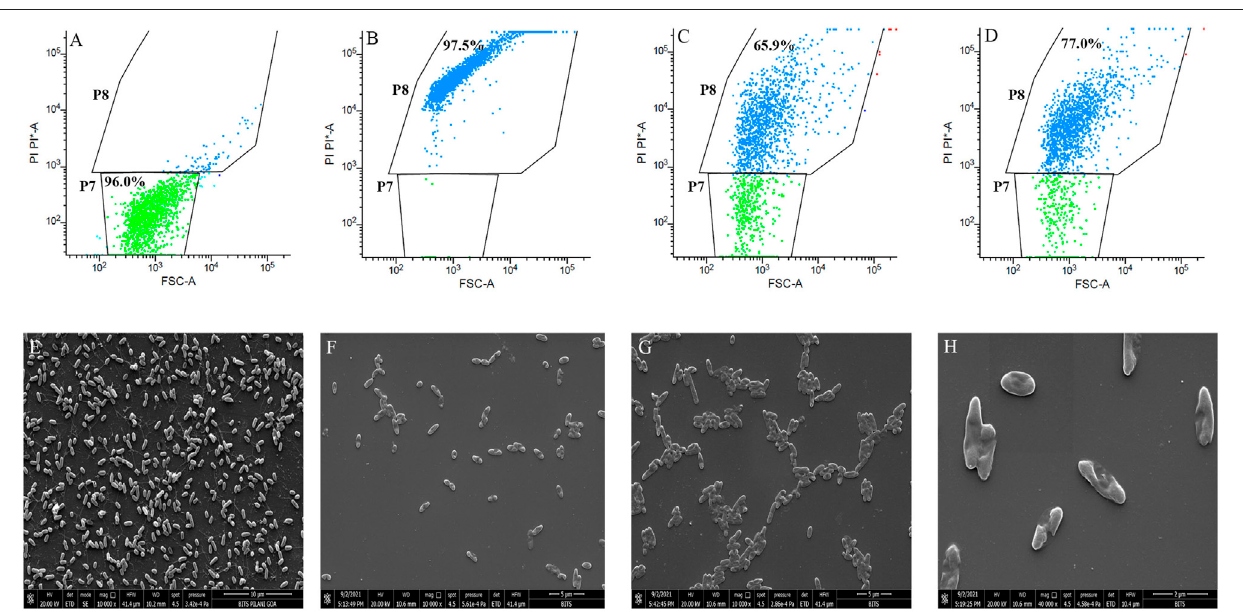
FIGURE5| CellmembranepermeabilityeffectofBG138.Datapresentedas fl owcytometerdotplotpro fi leofdifferenttreatments: (A) DMSO, (B) 70%Ethanol, (C) 32 μ g/ml, and (D) 64 μ g/ml. SEM images represent the effect of MIC on morphology of P. aeruginosa, DMSO (E) , MIC (F – H) .